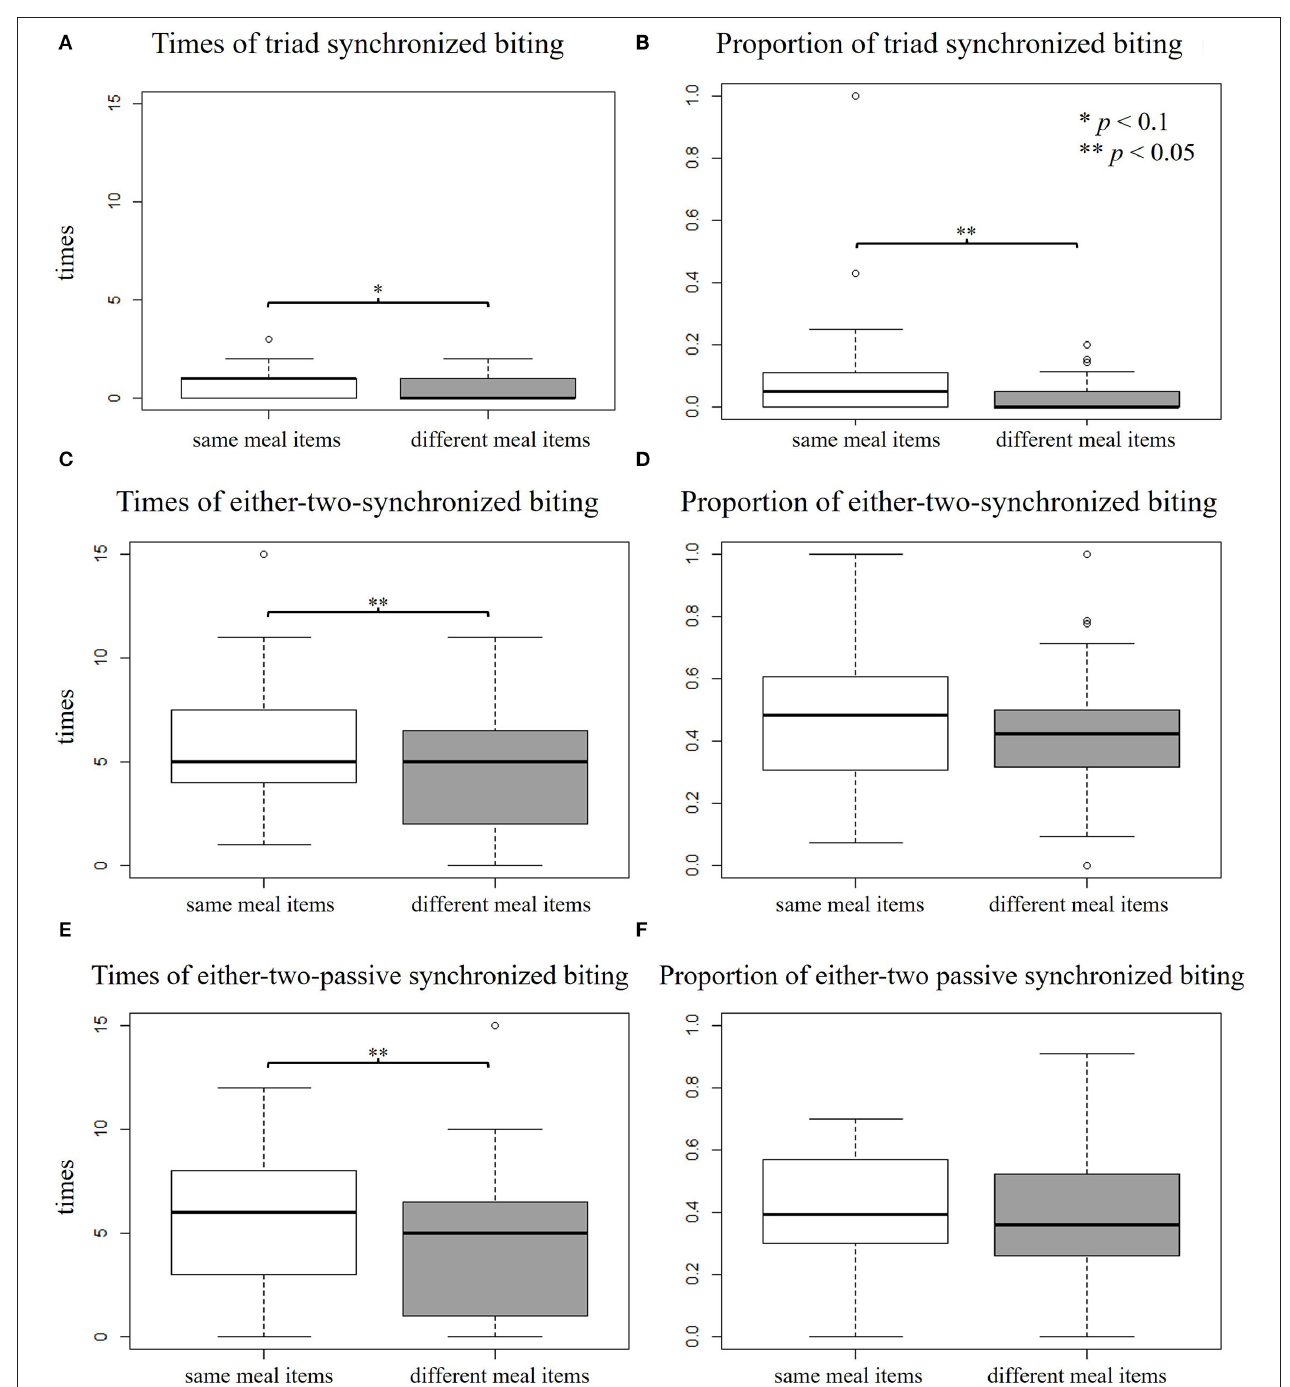
FIGURE 6 | Numbers of (A) triad synchronized bites over 5min and (B) proportions of triad synchronized bites to total biting. Numbers of (C) either-two-synchronized bites over 5min and (D) proportions of either-two-synchronized bites to total biting. Numbers of (E) either-two-passive synchronized bites over 5min and (F) proportions of either-two-passive synchronized bites to total